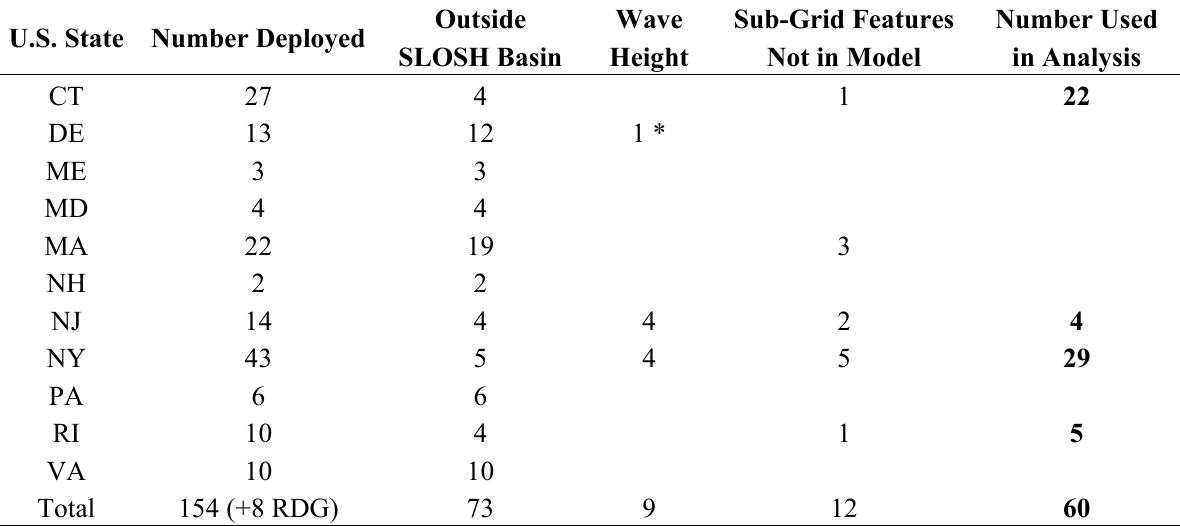
Table 5. The numbers of USGS storm surge sensors (SSS) deployed in each state, eliminated from the analysis, and used to verify the SLOSH model surge-plus-tides simulation results (* denotes that the sensor was both outside the SLOSH basin and measured waves, not surge or